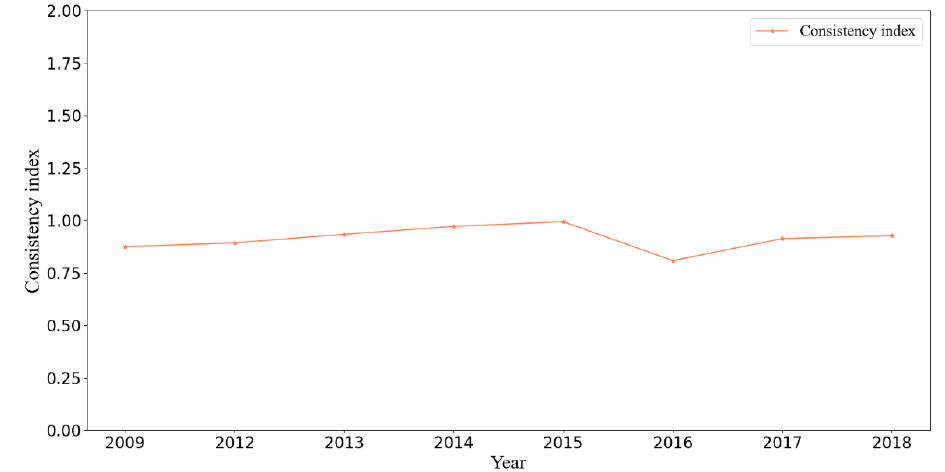
Figure 10. Fractal dimension consistency